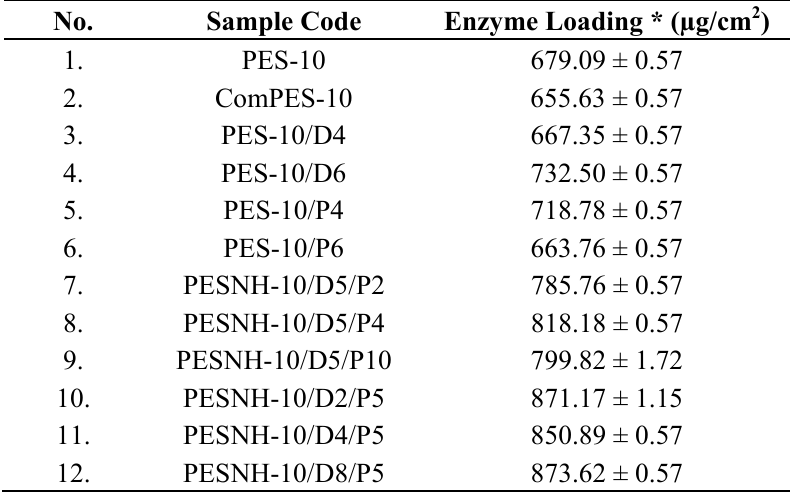
Table 1. Enzyme loading for all immobilized Mucor miehei